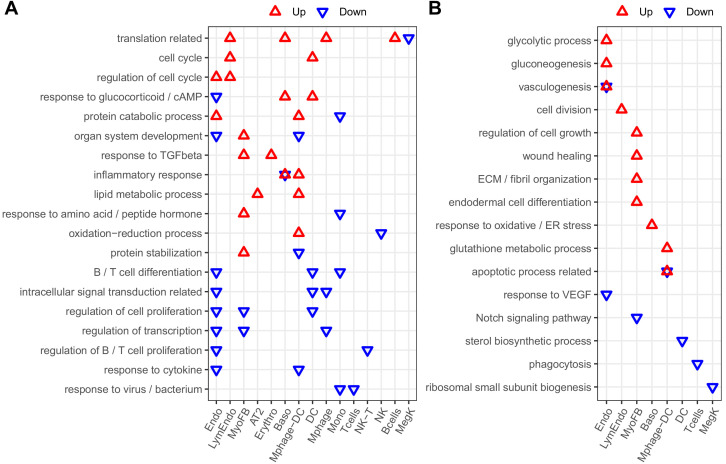
Enriched biological processes from differentially expressed genes from whole mouse lungs exposed to IH vs controls.This figure shows enriched biological processes that were not listed in Figure 4. Those biological processes enriched in one specific cell type were shown in (B) while others were shown in (A). Enrichment analysis was performed in the DAVID database using the top 200 up- and downregulated genes identified from each cell type. Redundant biological processes are merged into one category. Biological processes enriched in up- and downregulated genes are indicated by red and blue triangles, respectively.